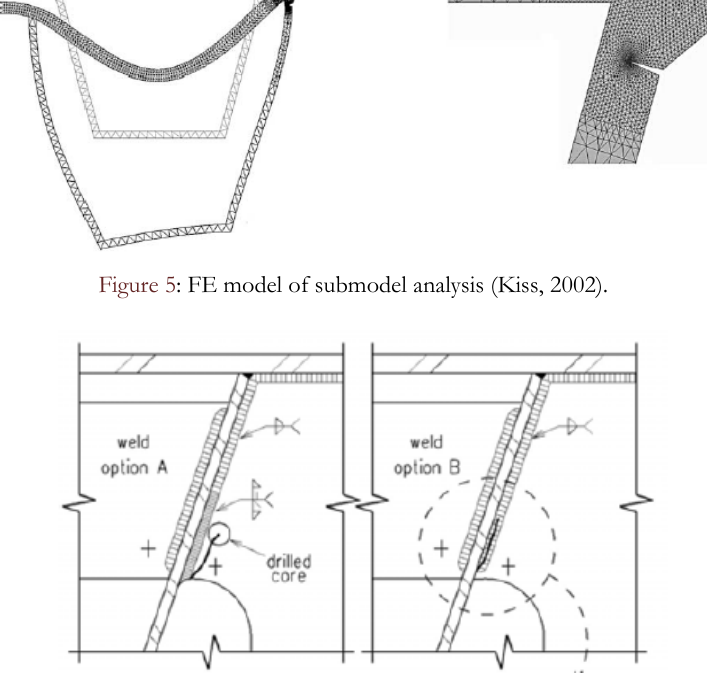
Figure 6: Cracks in weld options at near rib-to-diaphragm connection (Tsakopoulos, 2005).